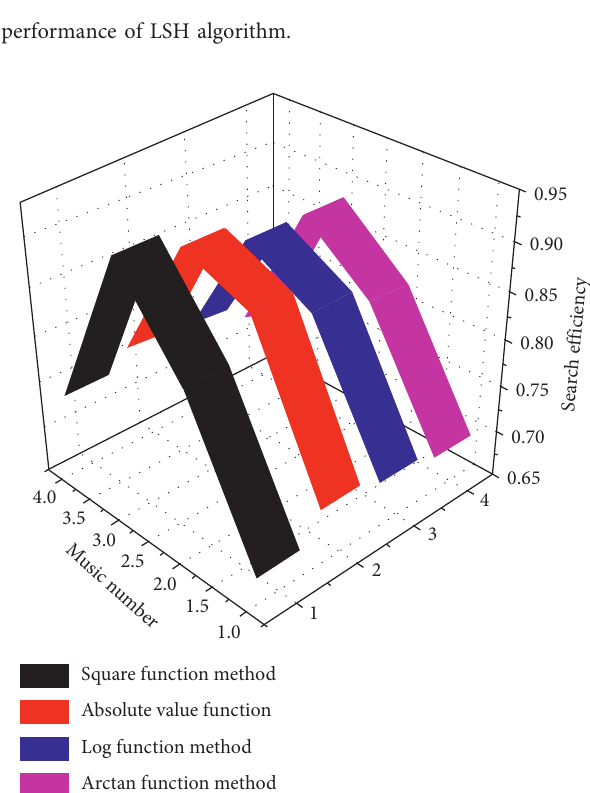
Figure 7: The retrieval performance of LS algorithm with different distance calculation